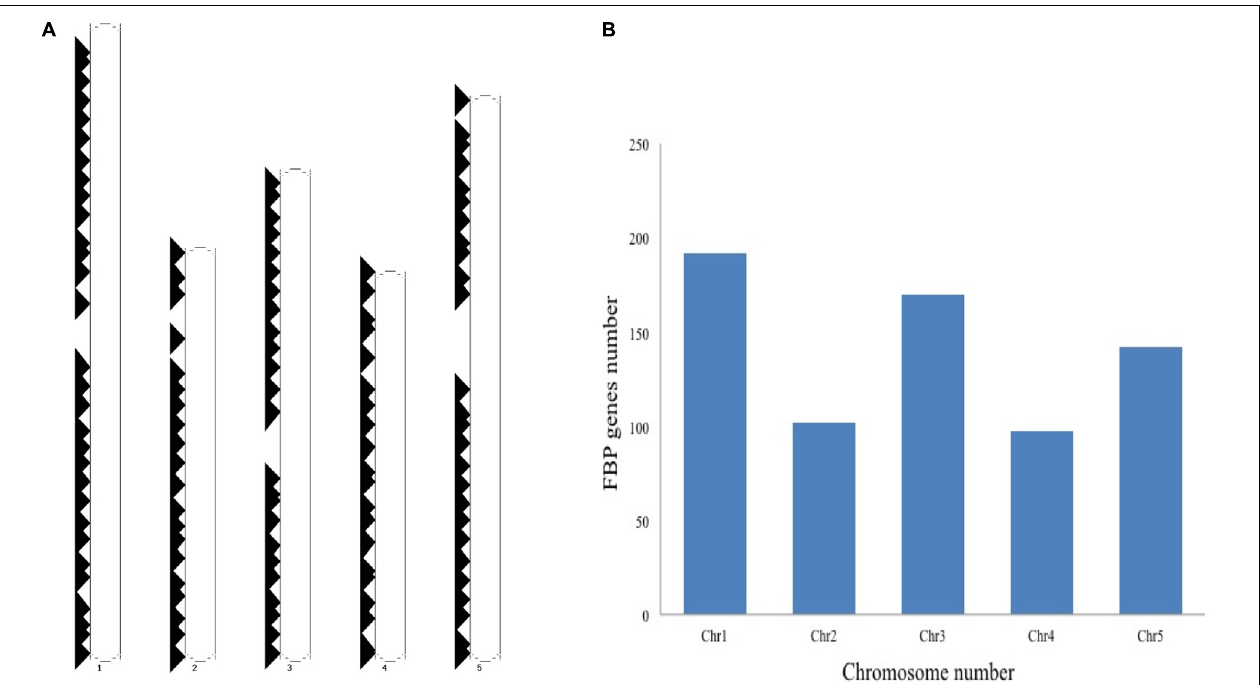
FIGURE 5 | Genomic distribution of Arabidopsis thaliana F-box genes. (A) Shows the distribution and localization of FBP genes on five different chromosomes of Arabidopsis thaliana . (B) Describes the positive correlation between the chromosome length and the number of FBP encoding genes. The longer chromosomes tend to have more FBP genes as compared to the smaller chromosomes except that more FBP genes are residing on chromosome 3 as compared to chromosome 5, which is larger than chromosome